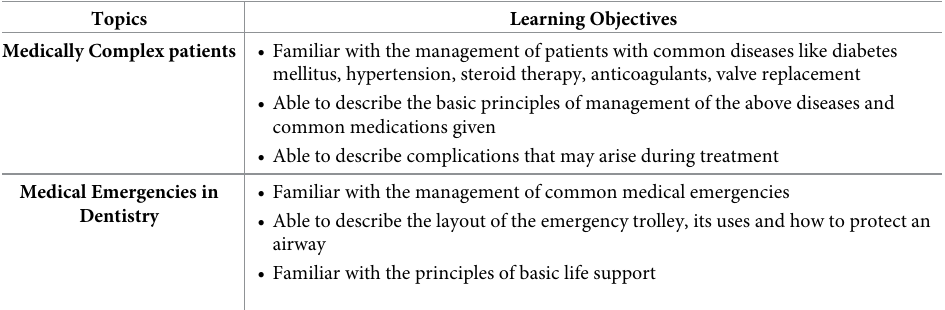
Table 3. Learning objectives by topics in the